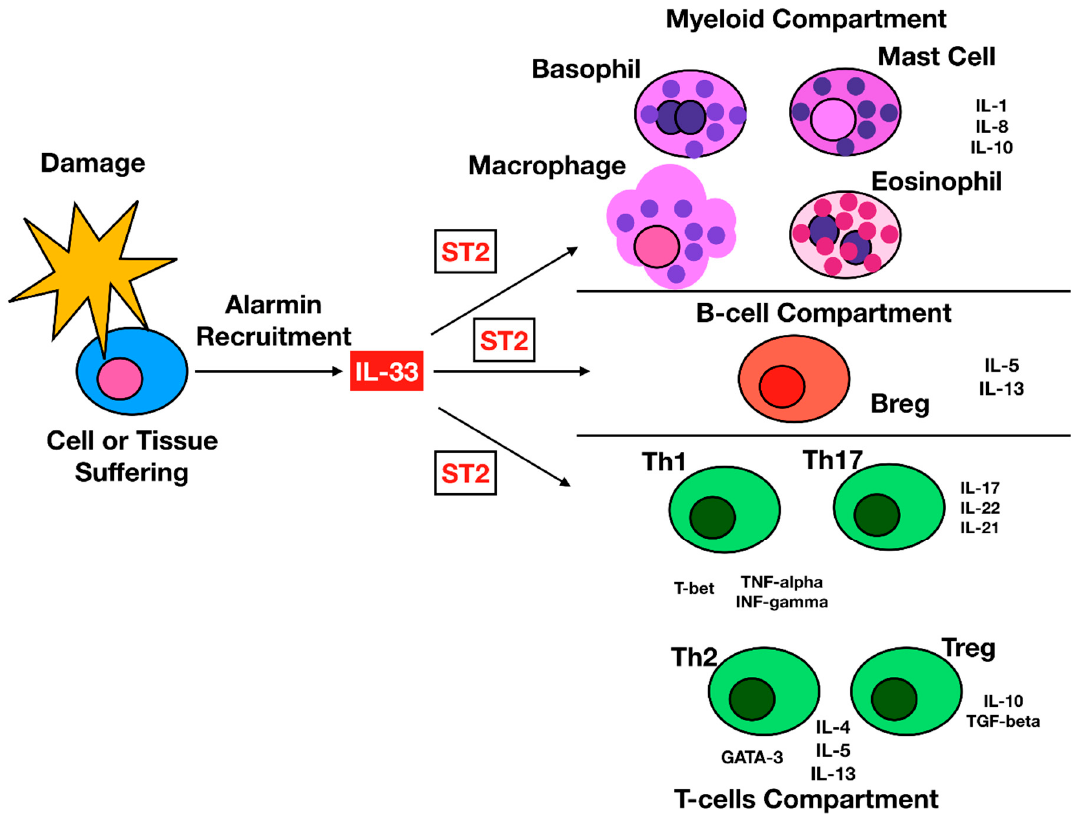
Figure 1. IL-33 Interleukin-33 (IL-33) signaling on immune cells. Tissue and cells damage lead to the release of IL-33 from these cells. IL-33 then signals to many different immune cells, enhancing their function and activating several immune mediators involved in inflammation and immune regulation.